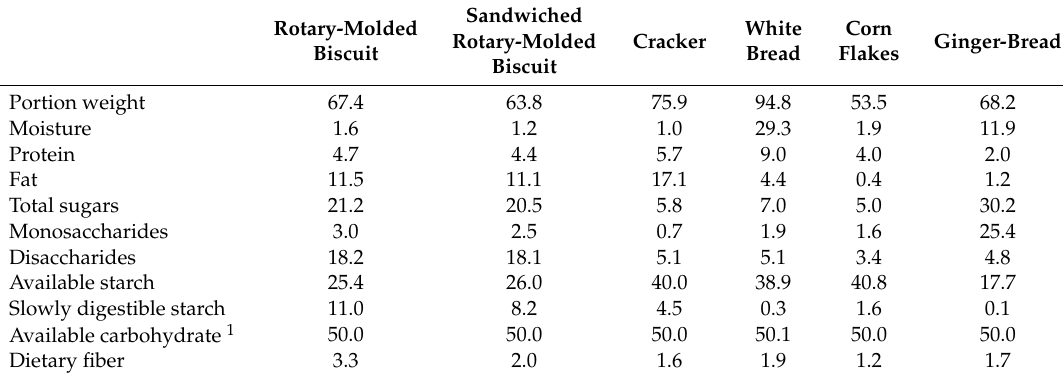
Table 1. Composition of study